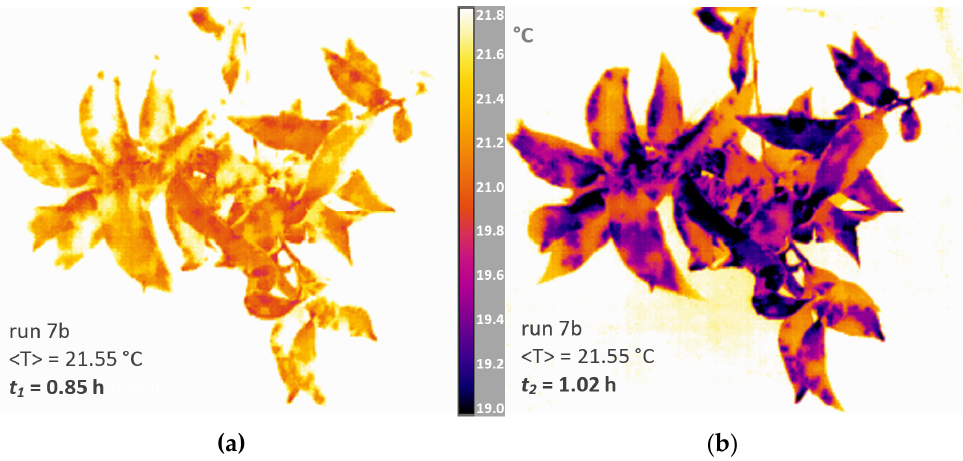
Figure 9. For run 7b, corresponding to Figure 7a, thermal images recorded ( a ) at the time t 1 = 0.85 h and ( b ) at the time t 2 = 1.02